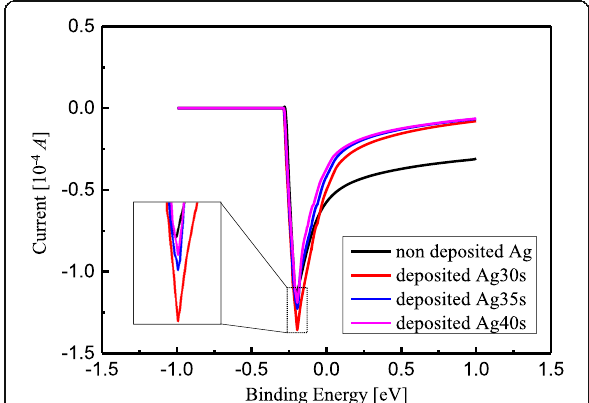
Fig. 7 Detection of Fe 3+ ions by Ag-loaded TiO 2 nanotube arrays with various concentrations